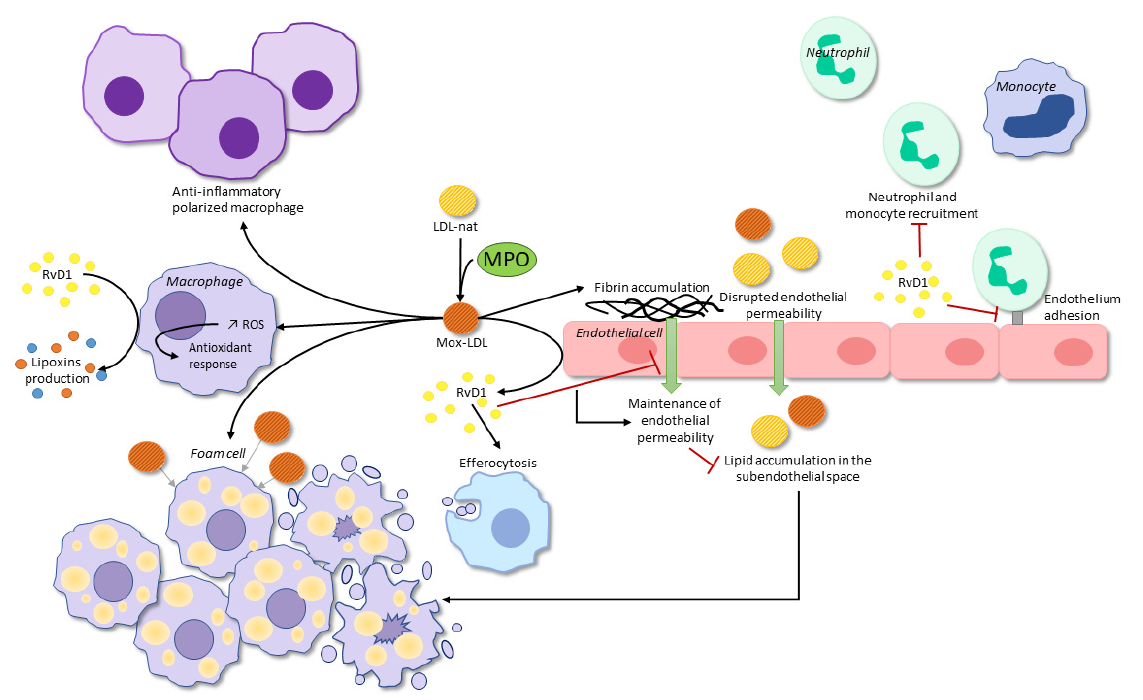
Figure 1. Effects of Mox ‐ LDLs on macrophages and endothelial cells. At the center of the figure: MPO oxidation products transform native LDLs (Nat ‐ LDLs) to MPO ‐ oxidized LDLs (Mox ‐ LDLs). Left: Mox ‐ LDLs can either be engulfed by macrophages and participate in the formation of foam cells or interact with macrophages. They influence the polarization of macrophages toward an anti ‐ inflammatory phenotype and induce an increase in intracellular reactive oxygen species (ROS), which leads to a compensatory response by stimulating the antioxidant response of macrophages. RvD1 stimulates the production of lipoxins, another SPM, by macrophages. Right: Mox ‐ LDLs also disrupt fibrin elimination at the surface of endothelial cells, which results in an accumulation of lipids, such as Nat ‐ LDLs or Mox ‐ LDLs, into the subendothelial space. When they interact with endothelial cells, Mox ‐ LDLs stimulate the release of resolvin D1 (RvD1), a specialized pro ‐ resolving mediator (SPM). RvD1 stimulates efferocytosis, which is essential to the resolution of inflammation and return to homeostasis, maintains endothelial cell permeability, and decreases the recruitment and adhesion of leukocytes to the endothelium.